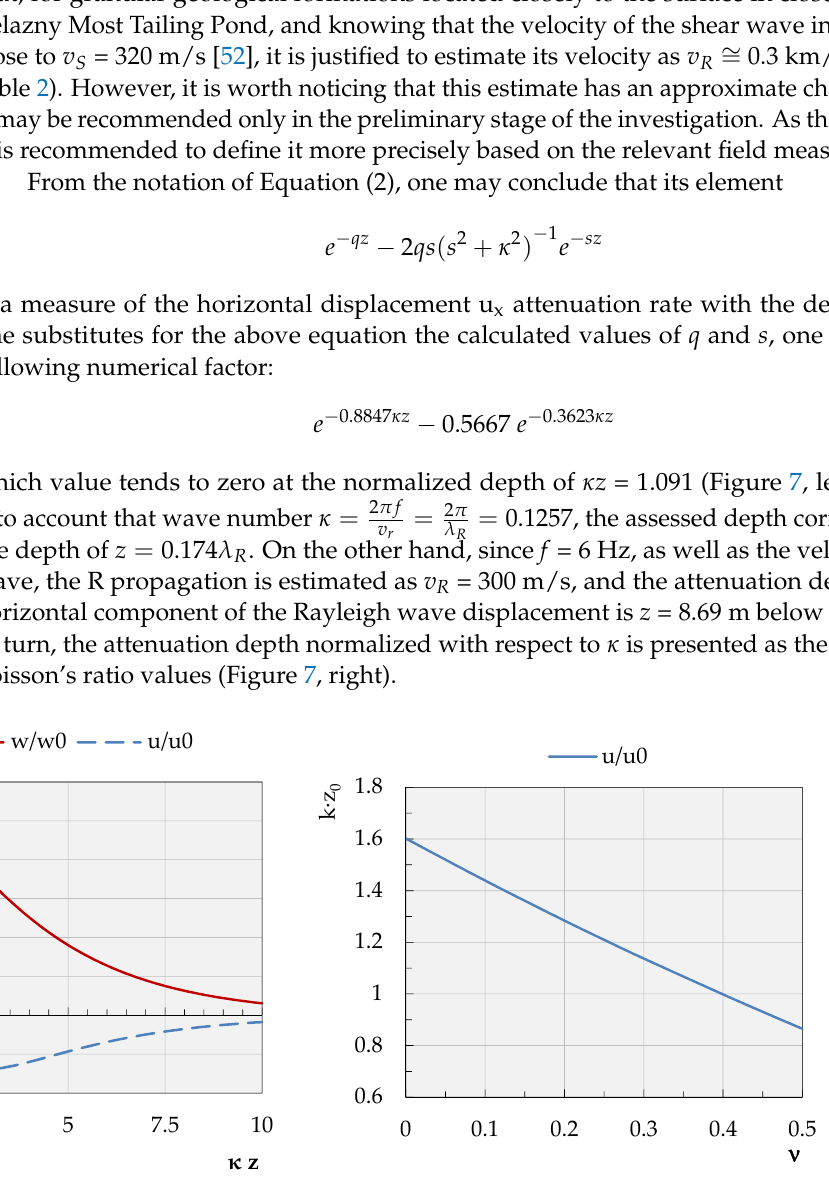
Figure 7. Changes in the values of the relative displacements ( left ) and normalized with respect to the κ , attenuation depth of the horizontal component of the wave R displacement in the function of Poisson’s ratio ν .